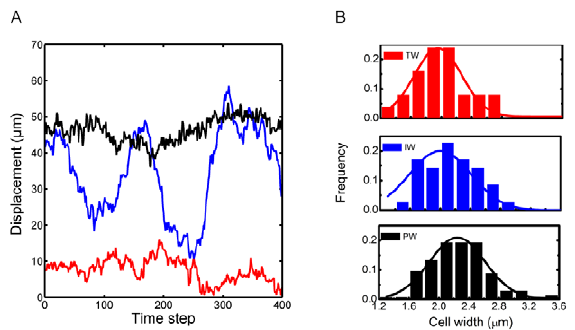
Figure 3. Distinguishing features of the motility modes. (a) Typical displacement calculated between every 100 frames of recordings for each motility mode. While TWs and PWs maintain low and high displacement values respectively, IWs seem to alternate between these two modes. (b) Distribution of cell width (measured at the widest point) for cells of each motility mode.